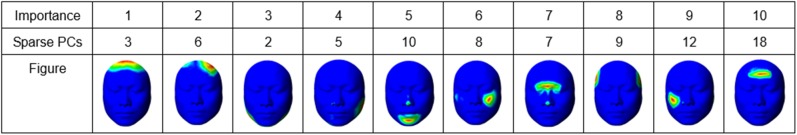
The proportion of each component in the most similar craniofacial comparison.